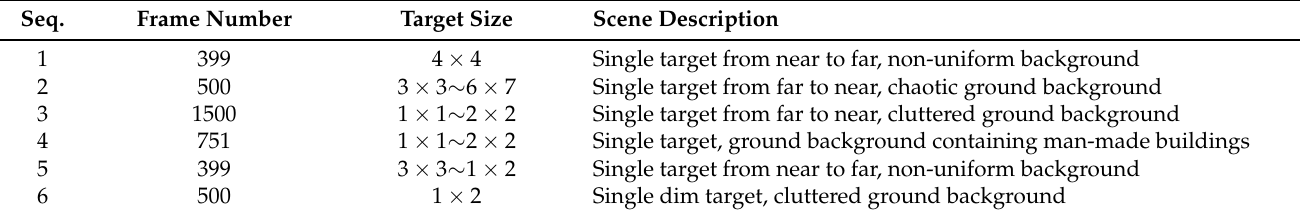
Table 1. Details of different image sequences.